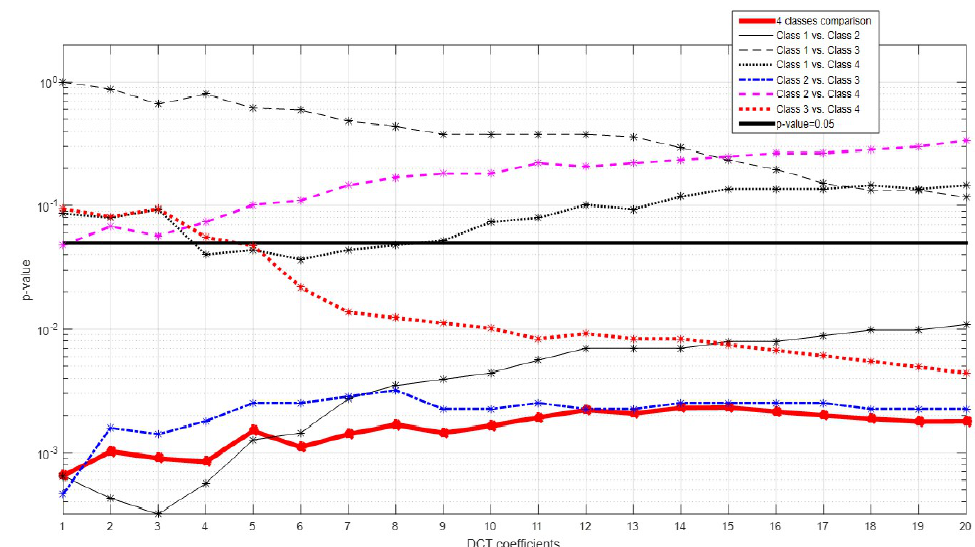
Figure A2. Graphical representation of p -values of the statistical comparisons regarding each coefficient extracted from the DCT applied to the original back-scattered signal. Vertical axis is in logarithmic scale. Class 1—“no particle trapped”; Class 2—“PMMA particle trapped"; Class 3—"Polystyrene particle trapped"; Class 4—“Living yeast cell